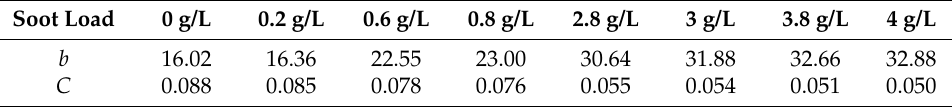
Table 4. Parameter identification results of R d and C